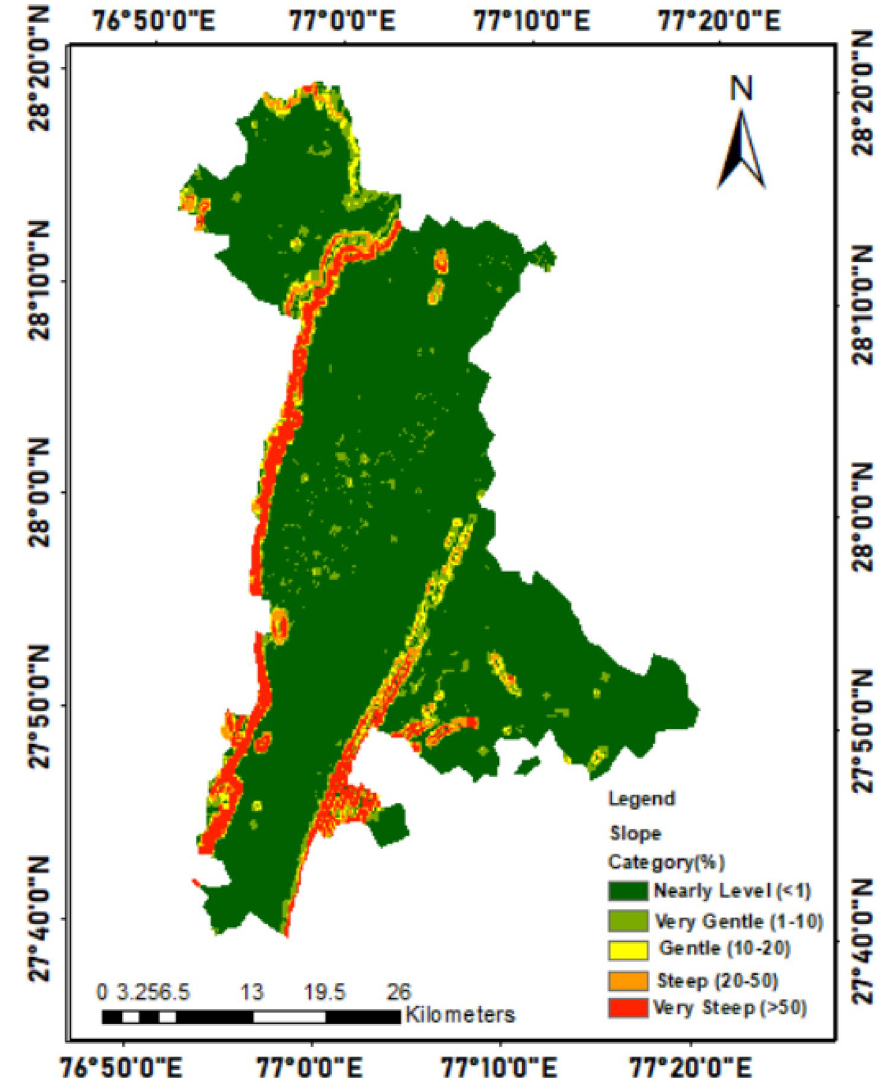
Fig. 7 Slope map of study